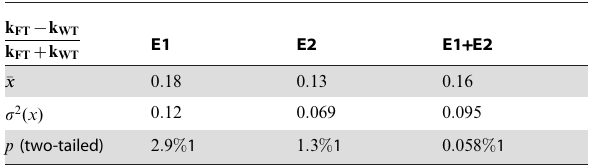
in % for groups E1 WT = FT